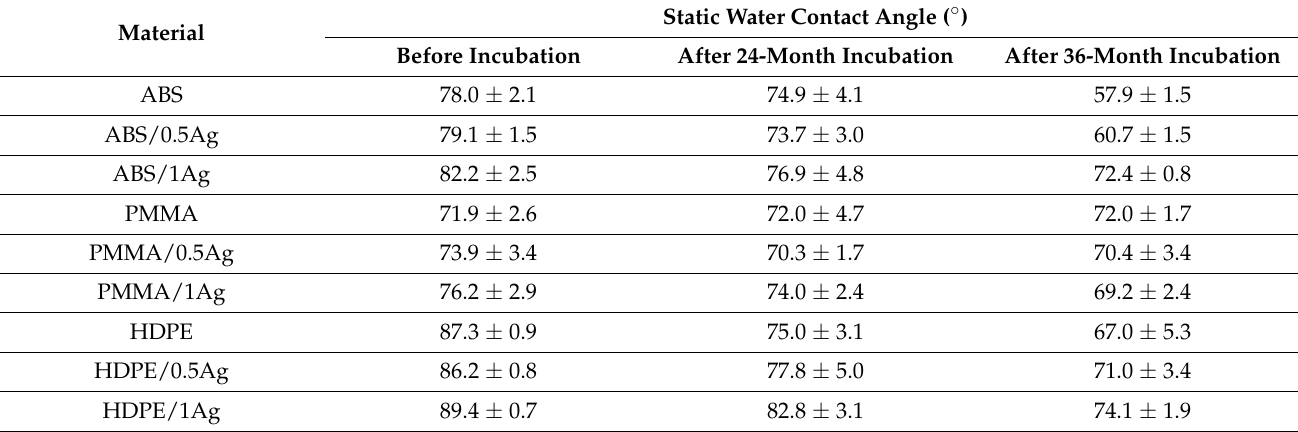
Table 2. Results of the static water contact angle of polymers and composites modified with 0.5 wt.% and 1.0 wt.%